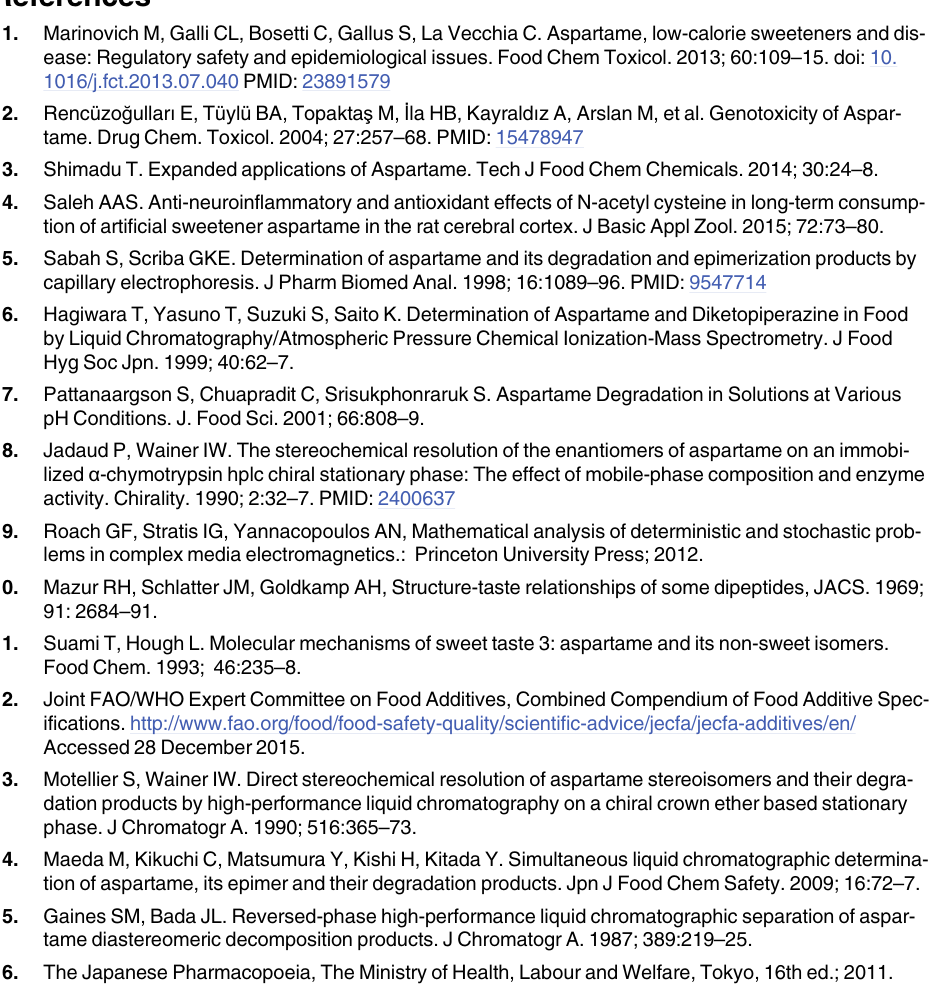
PLOS ONE | DOI:10.1371/journal.pone.0152174 March 25,